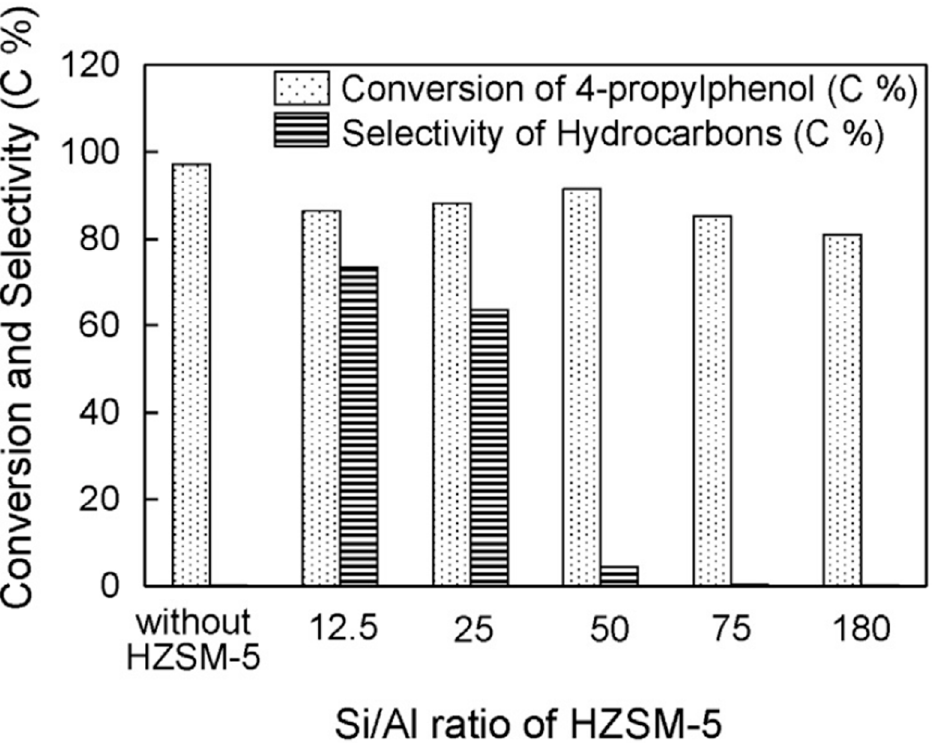
Figure 11. Conversion and product selectivity in HDO of eugenol at 240 °C under 50 bar hydrogen after 4 h over Pd/C catalyst together with HZSM-5 with different acidity [27].